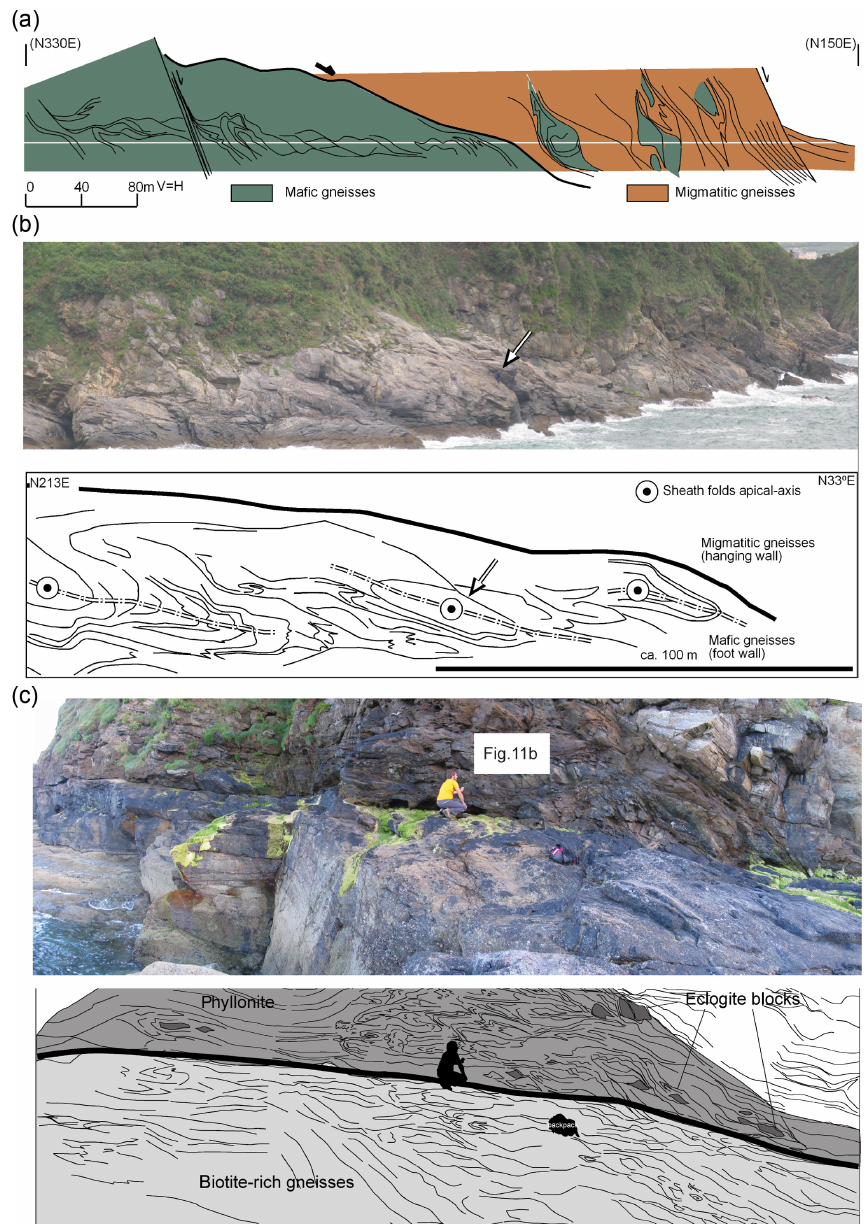
Figure 10. Coastal sections of the basal thrust (see Figs. 2a and 12a for locations). (a) Continuous section showing the contact between the mafic gneisses and the migmatitic gneisses. The white line represents the sea level. (b) Elliptical sections in sheath folds of decametric size in the lower domain of the basal thrust. The arrow points to an fisherman for scale, also used as reference in the sketch outlining the S 2 foliation underneath. (c) Phyllonitic domain in the basal thrust. Structures related to this domain are outlined in the sketch below the